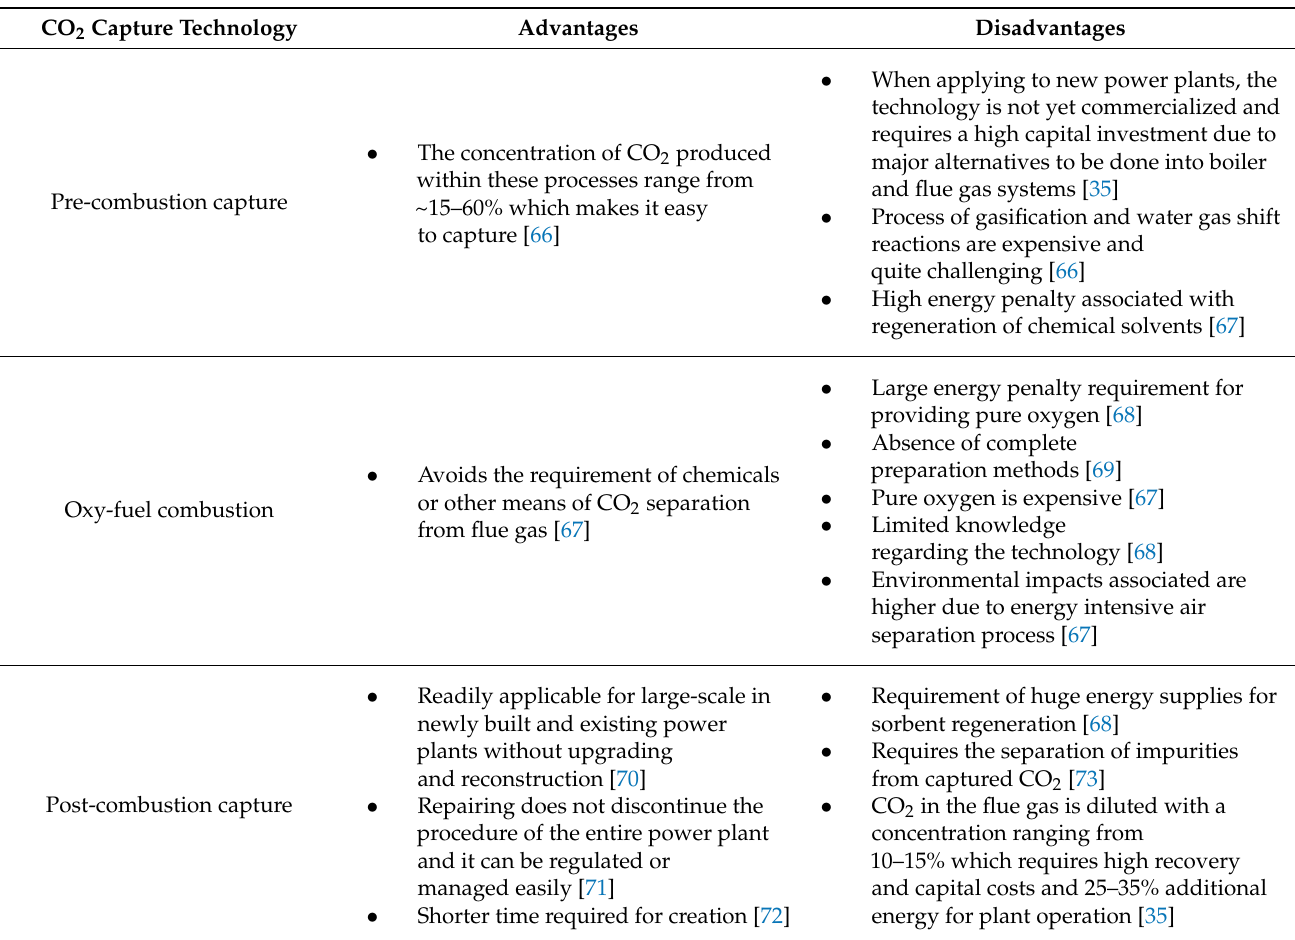
Table 2. Comparison of the three main carbon capture